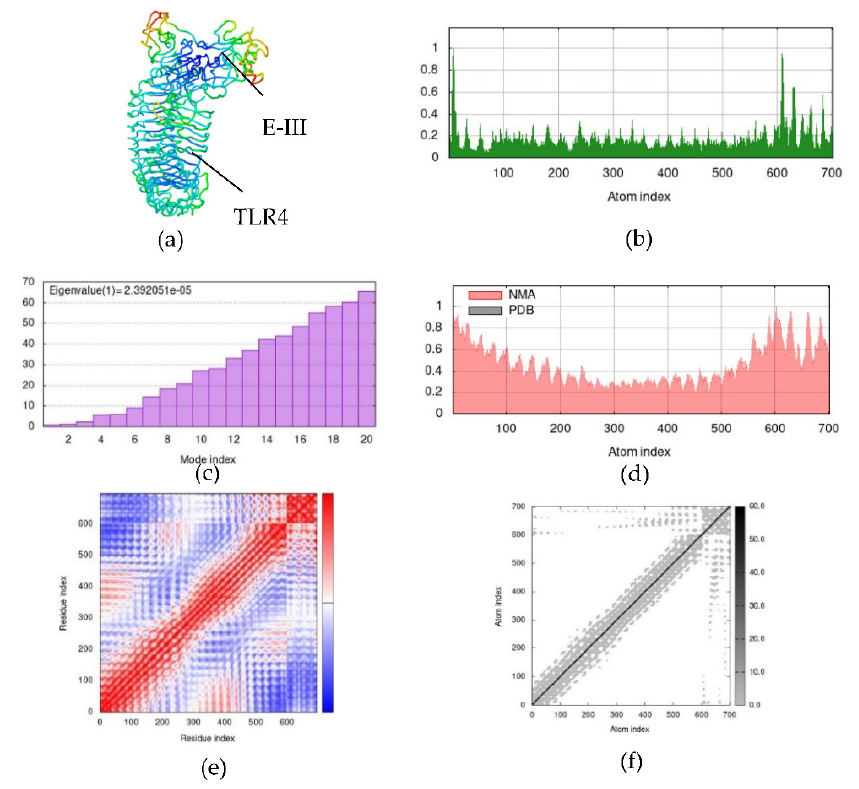
Figure 9. Normal mode analysis (NMA) of EIII–TLR4 docking complex by iMODs. ( a ) EIII and TLR4 docking complex; ( b ) main-chain deformability; ( c ) the eigenvalue; ( d ) B-factor values; ( e ) covariance map; ( f ) elastic network of model.